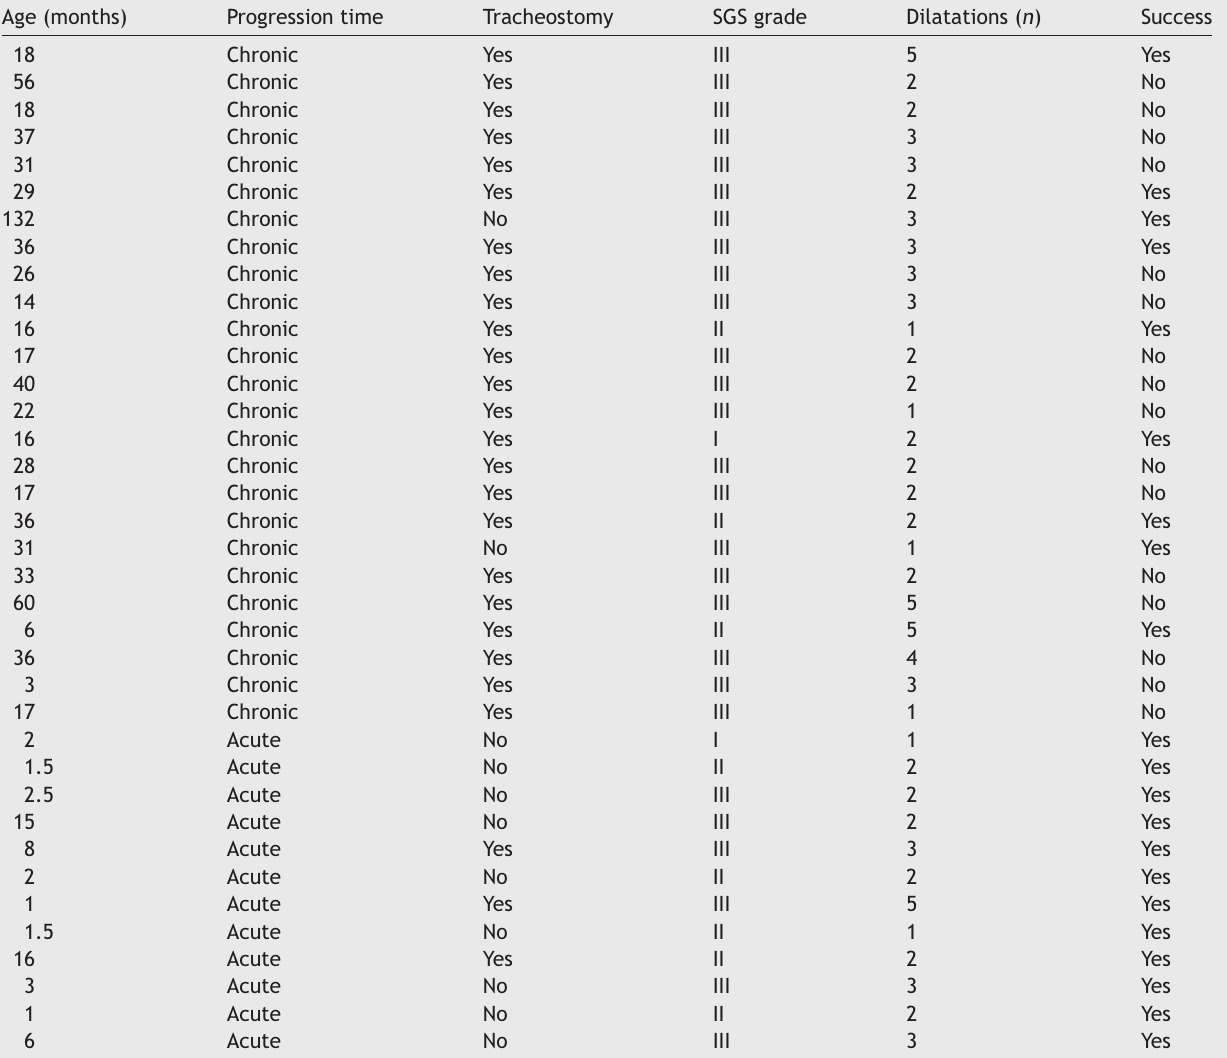
Description of cases with data regarding age, duration of the disease, presence of tracheostomy, degree of stenosis, number of dilatations, and therapeutic